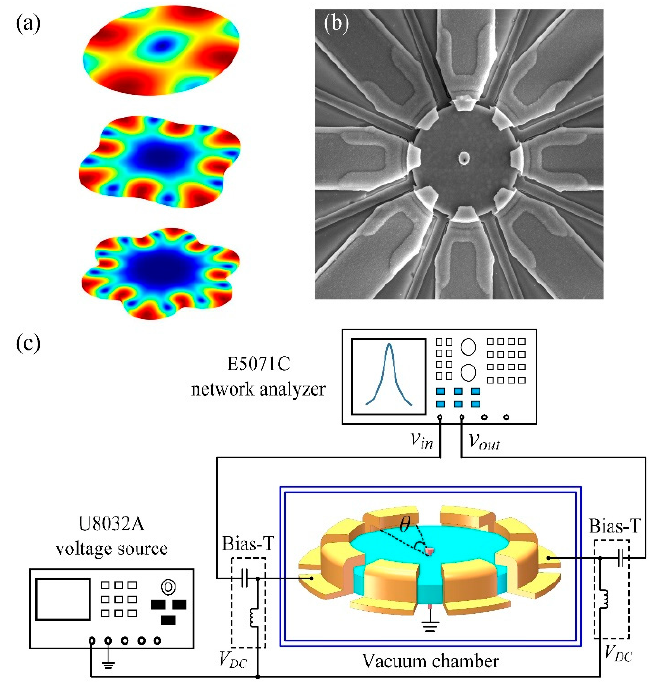
Figure 1. The mode shapes of the 2nd, 4th, and 6th WGMs ( a ); the scanning electron microscope (SEM) photograph of the fabricated resonator ( b ); and the measurement setup of the WGM resonators ( c ).